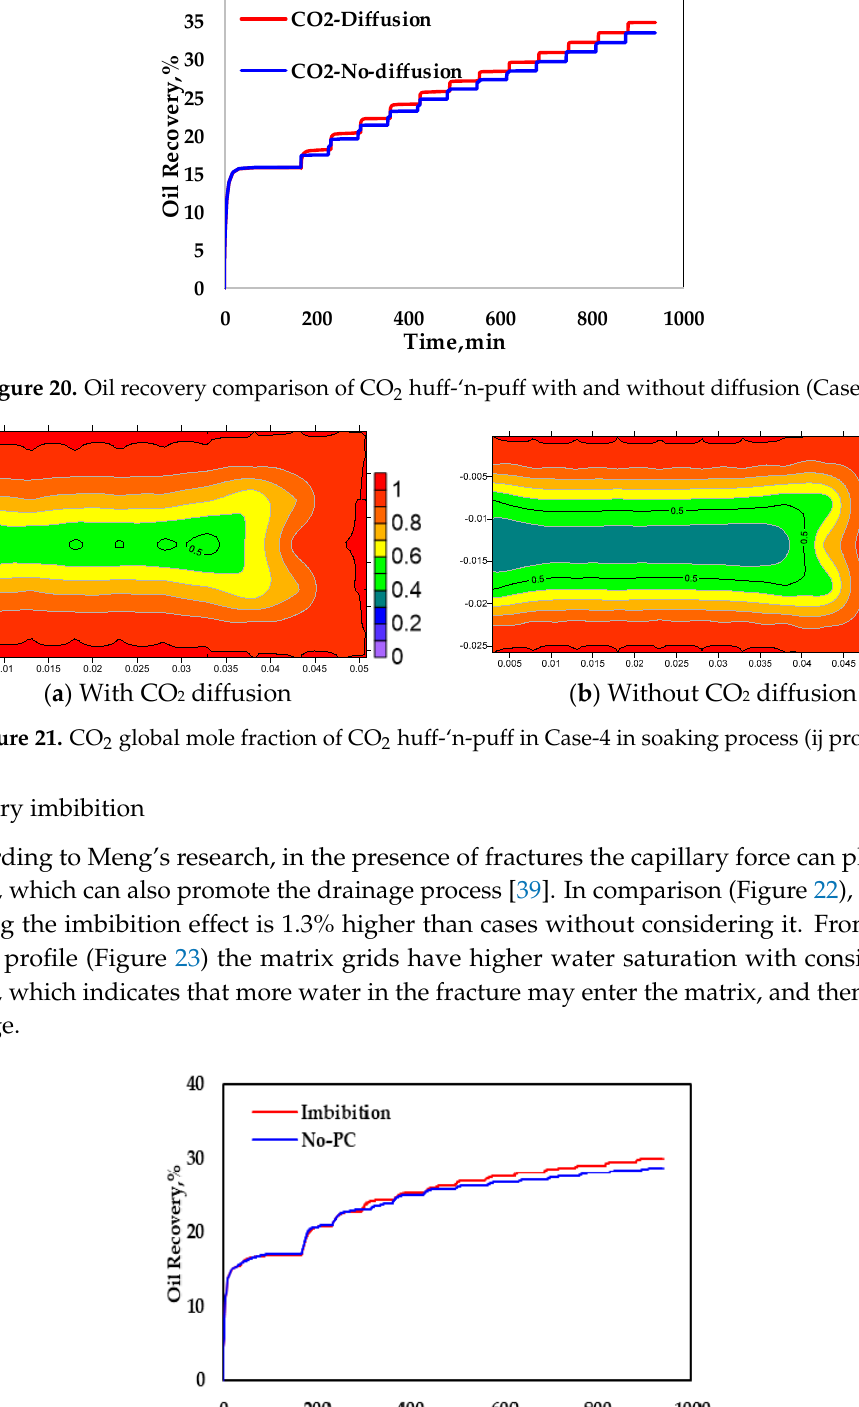
Figure 19. Oil saturation of different fluids in Case-4 in production process (ij profile).